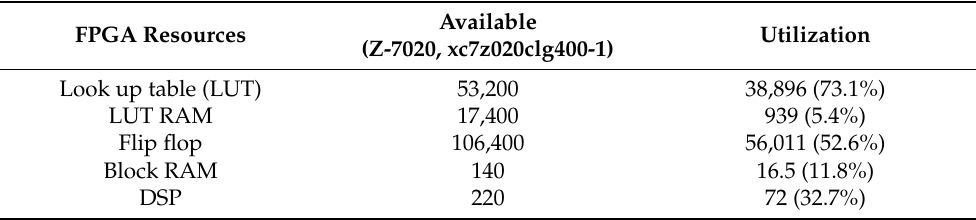
Table 3. Usage of the FPGA resources of the proposed processor in the target FPGA (Z-7020).